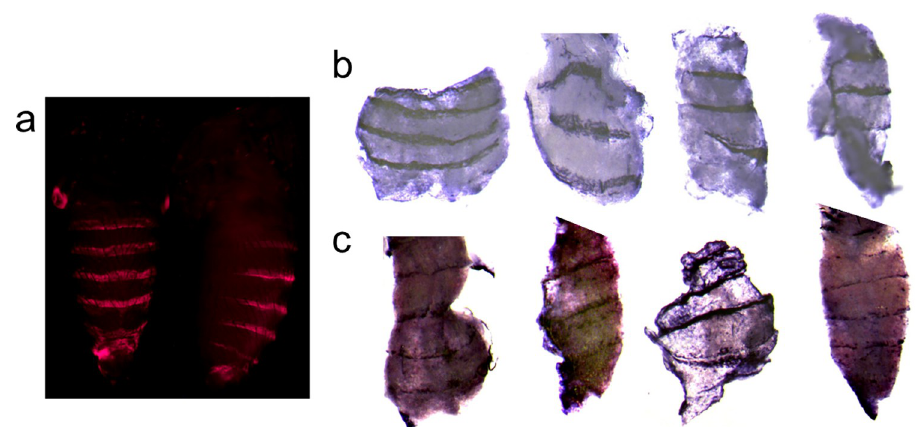
Fig 9. ISH signals showing that the hh cDNA and wg cDNA ectopic expression patterns correlate with the gut y stripe CRE reporter assay. a, DsRed reporter assay showing the activity of the gut y stripe CRE at stage P10. This construct drives reporter expression in horizontal stripes across the abdomen. b, ISH signal of the ectopic expression of hh cDNA along the tergites of P10 pupae of D . guttifera showing a stripe pattern. c, ISH signal showing the ectopic expression of wg cDNA along the tergites of P10 pupae of D . guttifera . The probe is detected in horizontal stripes. Negative controls without any significant abdominal staining are shown in S14